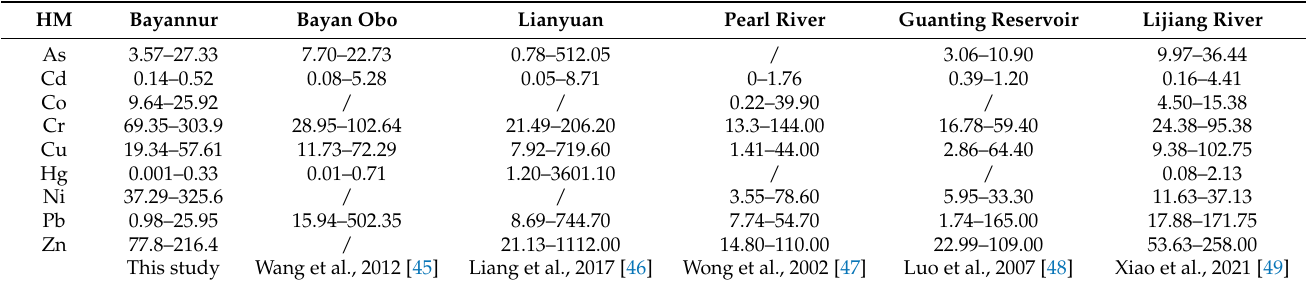
Table 1. The ranges of the heavy metal content of soil (sediment) from Bayannur and other regions in China